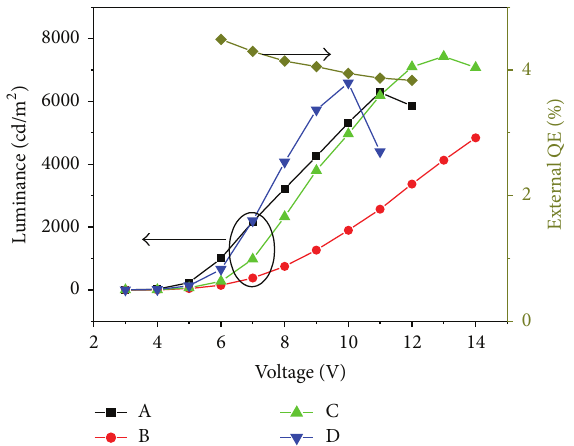
Figure 4: The luminance-voltage characteristics of four organic devices External power efficiency of device B was setting in the right bar of figure at different forward biases. Figure 5: Normalized EL spectra of four organic devices at 12V